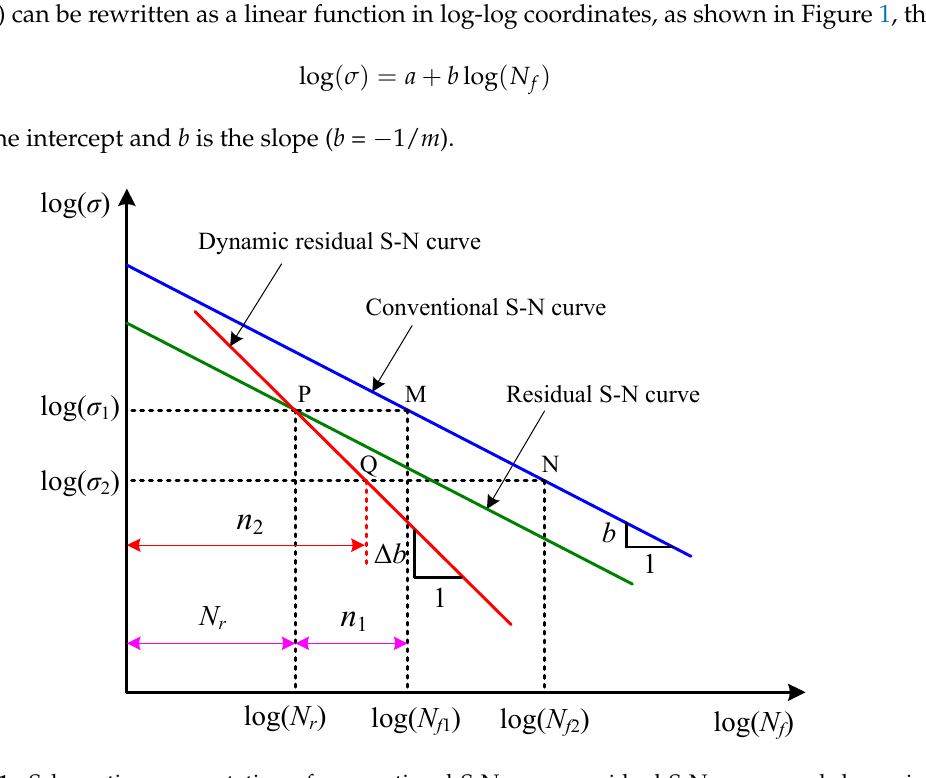
Figure 1. Schematic representation of conventional S-N curve, residual S-N curve, and dynamic residual S-N curve.